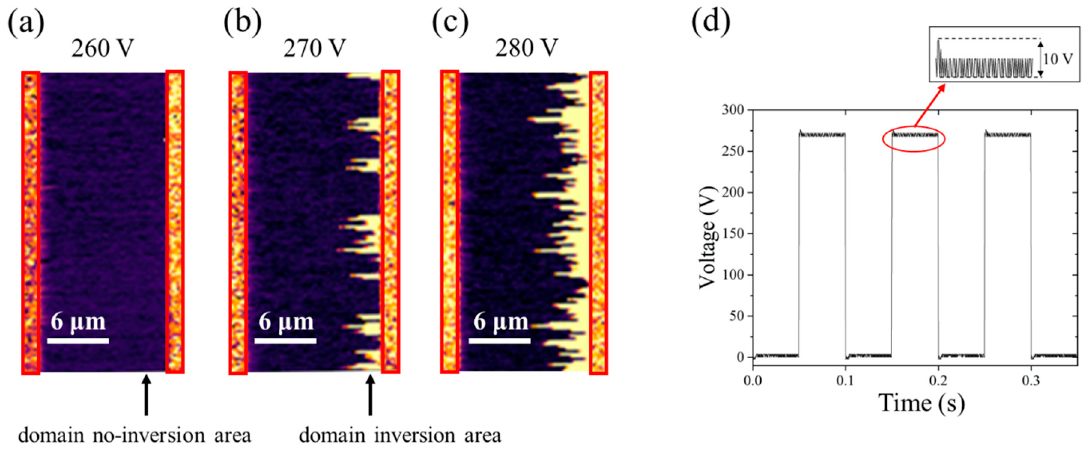
Figure 6. Domain inversion images of LNOI annealing at 350 ◦ C at 260 V ( a ), 270 V ( b ) and 280 V ( c ). Electrical pulse waveform when the voltage was 270 V ( d ). Table 1. The domain inversion voltage of LNOI.